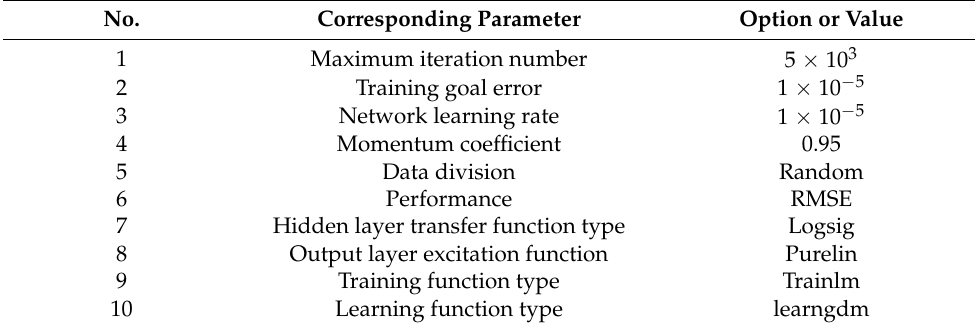
Table 7. Parameters in the ANN model.